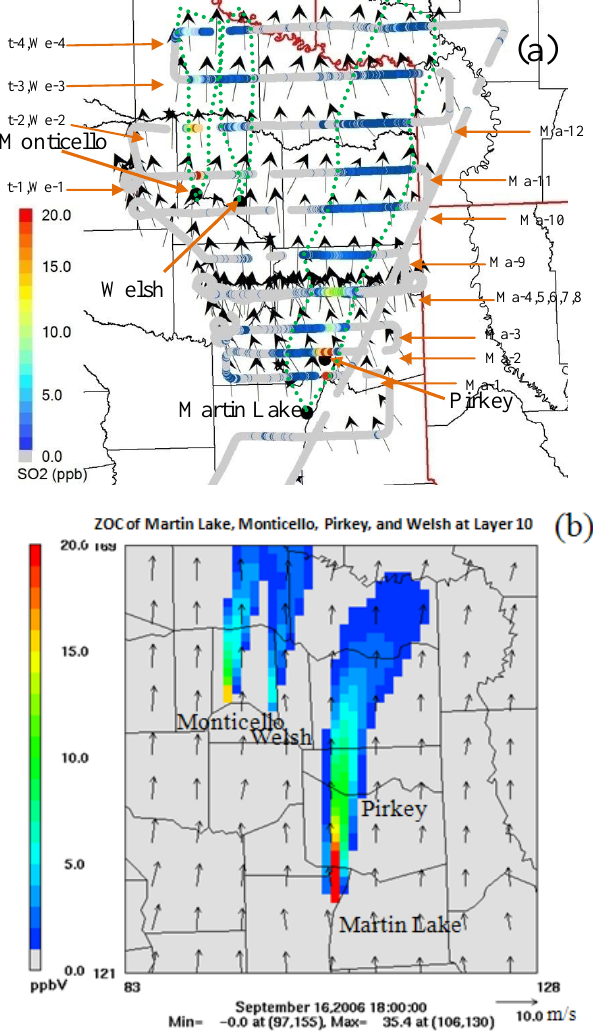
Fig. 2. (a) Observed PPPs of Martin Lake, Monticello, Pirkey, and Welsh on 16 September 2006. The black dots show the locations of the power plants. PPPs are identified by measured SO 2 enhancement (color gradient in the figure), as outlined by the green dash lines. Measured wind vectors are presented on the plume transect. The geographical redlines are the state boarder-lines. (b) Simulated PPPs of Martin Lake, Monticello, Pirkey, and Welsh at 18:00 GMT (600 ∼ 700m) (local time: 12:00)